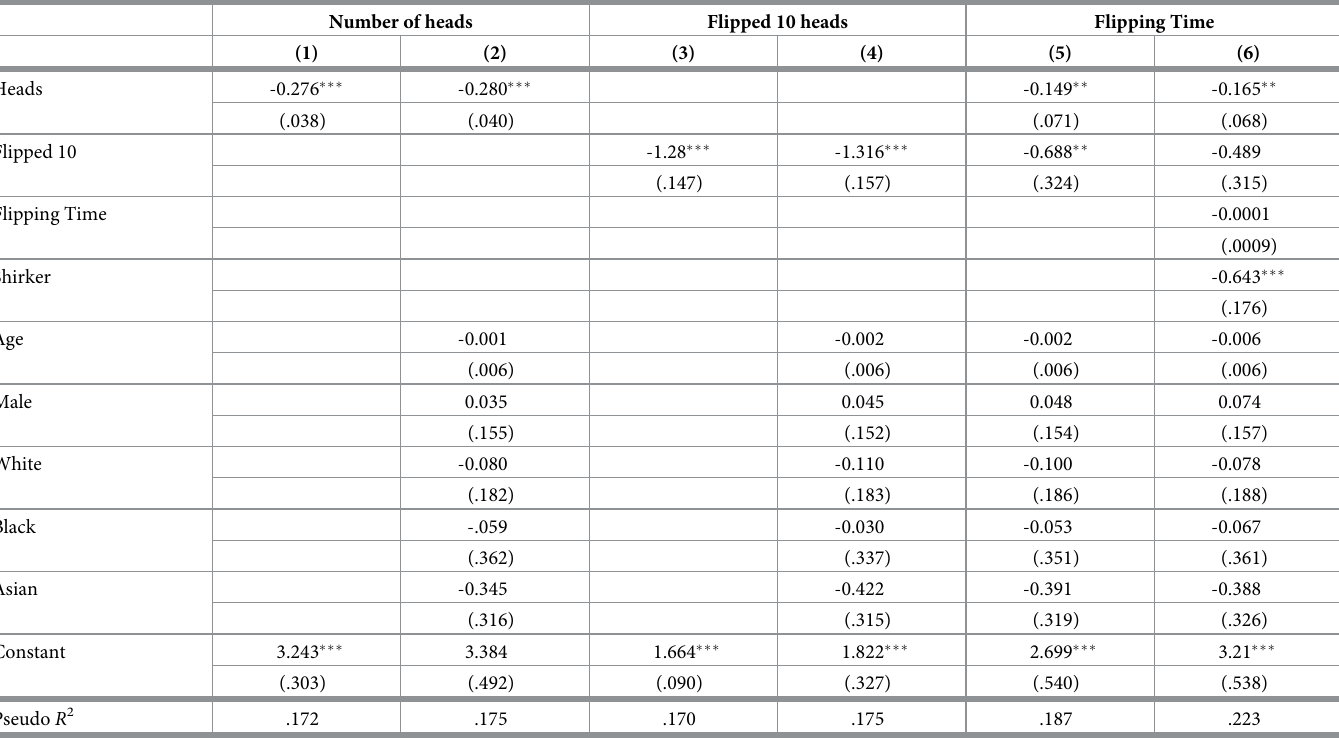
Table 5. Ex-post